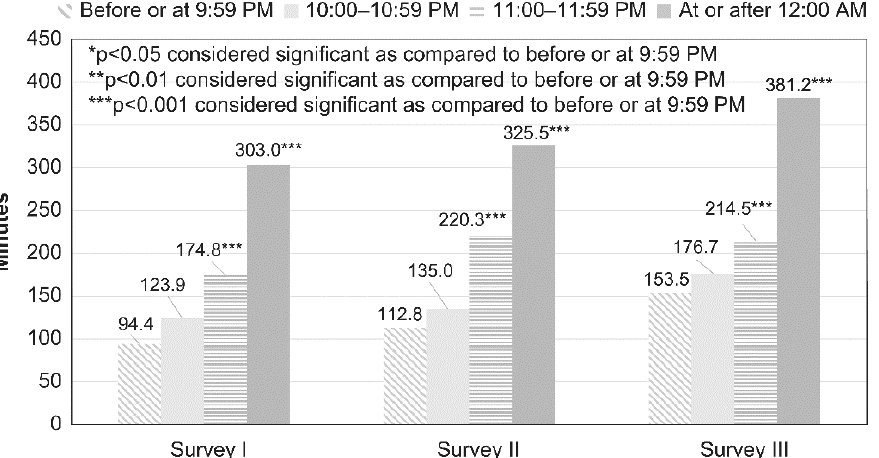
Figure 3. Comparison of sleepiness during classes according to bedtime on weekdays in each survey. For each bedtime on weekdays, the comparison of degree of sleepiness during classes between each survey was performed using χ 2 analysis. For each bedtime on weekdays, a comparison of internet use duration (in minutes) on weekdays among groups as per survey year was made using ANOVA. A post hoc analysis between the group from survey III and the groups from the other surveys (survey I and II) was performed using Dunnett’s test.